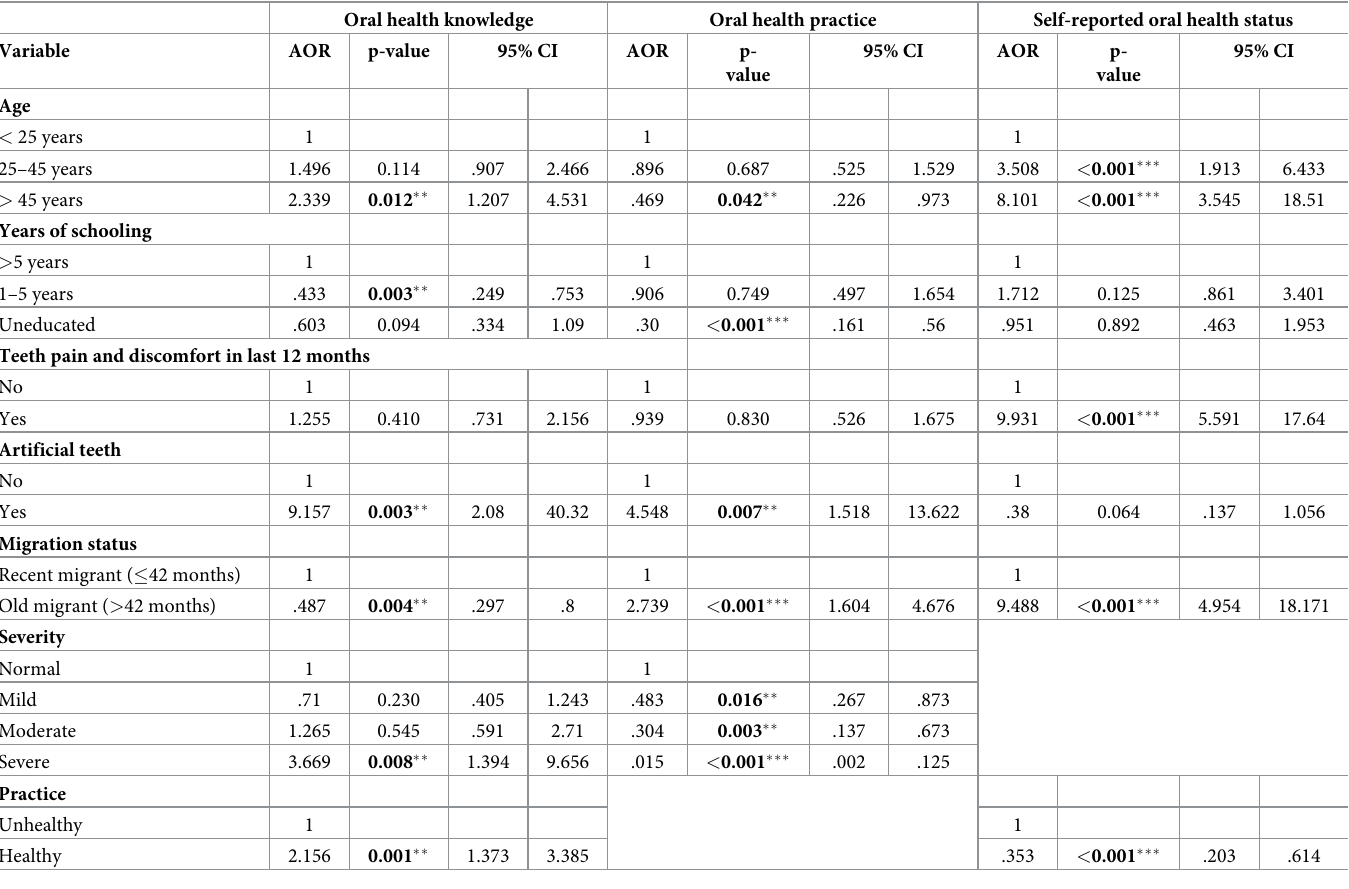
Table 5. Logistic regression of oral health knowledge, practice, and self-reported oral health status (N =